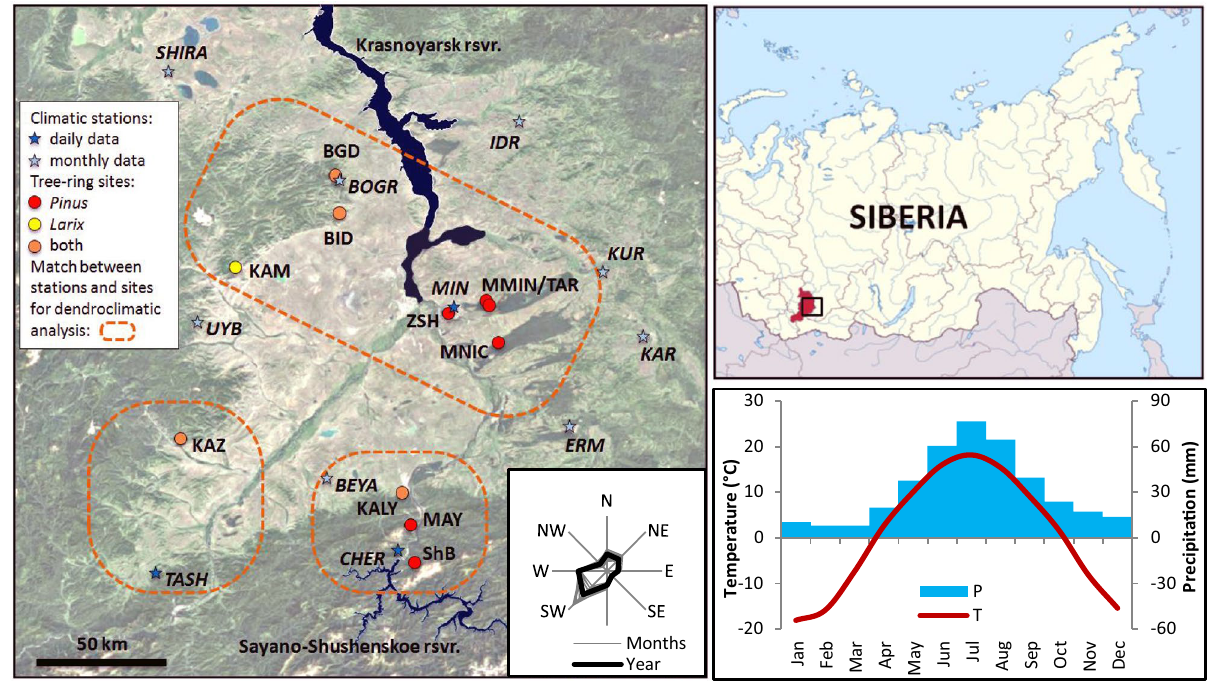
Figure 1. The study area: Khakass-Minusinsk Depression (satellite imagery basemap acquired from ArcGIS Map Wiever, Esri; https:// www. arcgis. com/ home/ webmap/ viewer. html). Asterisks represent climatic stations with available daily (dark) and monthly (light) data; circles represent tree-ring sampling sites (red, Pinus sylvestris L.; yellow, Larix sibirica Ledeb.; orange, both sp.); dash-line areas show areas around climatic stations MIN, TASH, and CHER where their data were used to analyze climatic response of tree-ring chronologies. The inset map shows the location of the study area. Climatic diagram is based on monthly regional data series REG (see “Methods”; 1936–2014). Wind rose shows mean repeatability of wind directions at